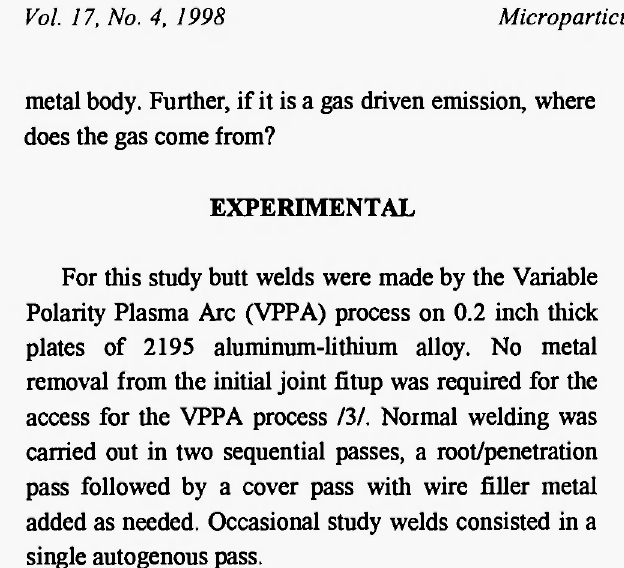
Fig. 2: "Smut" on surface adjacent to crack in repaired weld bead.